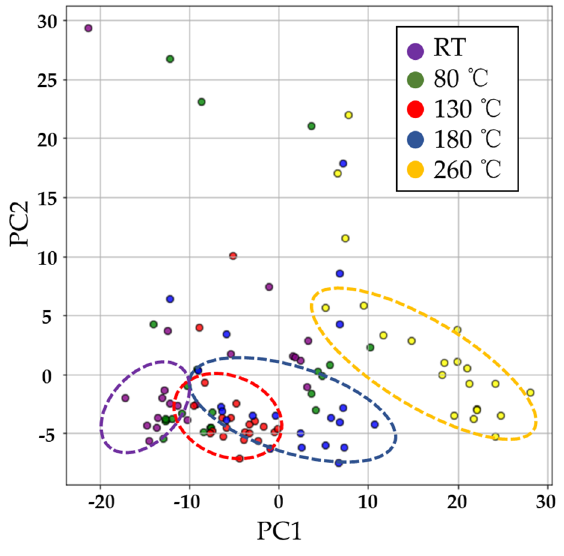
Figure 7. PCA results of heating analysis of LV cable in ordinary air using array A.